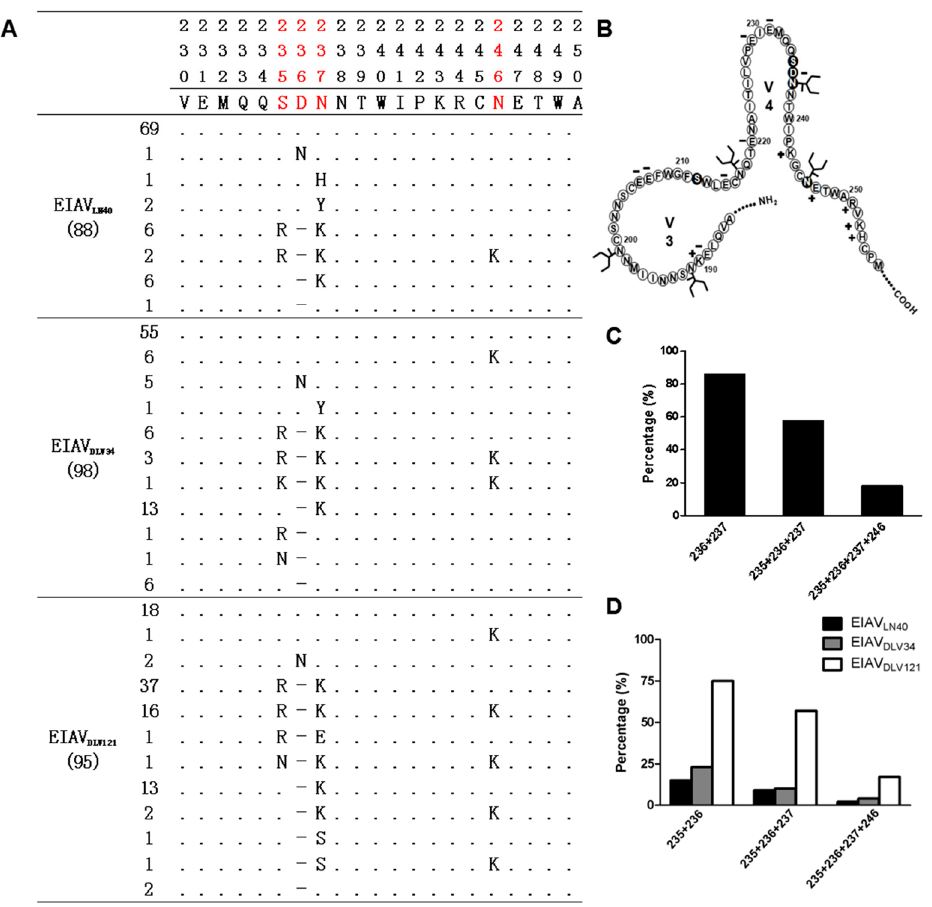
Figure 2. Distribution of the consensus mutations located in the V3 and V4 regions and schematic structural representations. ( A ) Red letters are defined as critical consensus mutation sites displayed within the Env region during the EIAV attenuation process. ( B ) Schematic figure of the EIAV DLV121 V3 and V4 regions. N-Glycosylation sites are shown as branched lines. ( C ) Comparison of the proportions of several combined mutations at 235, 236, 237, and 246 for the whole mutants. ( D ) The percentages of these combined mutations at the key stages of vaccine development (EIAV LN40 , EIAV DLV34 , and EIAV DLV121 ).